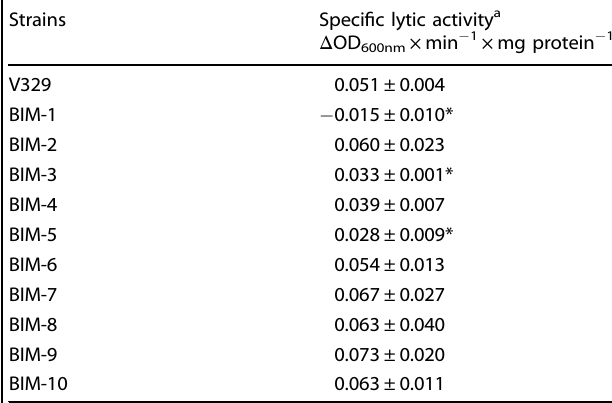
a Values represent the means ±standard deviations from three indepen- dent replicates. *indicate values that were statistically different ( p <0.05) from those of the wild-type strain using an unpaired t -test with Welch ’ s